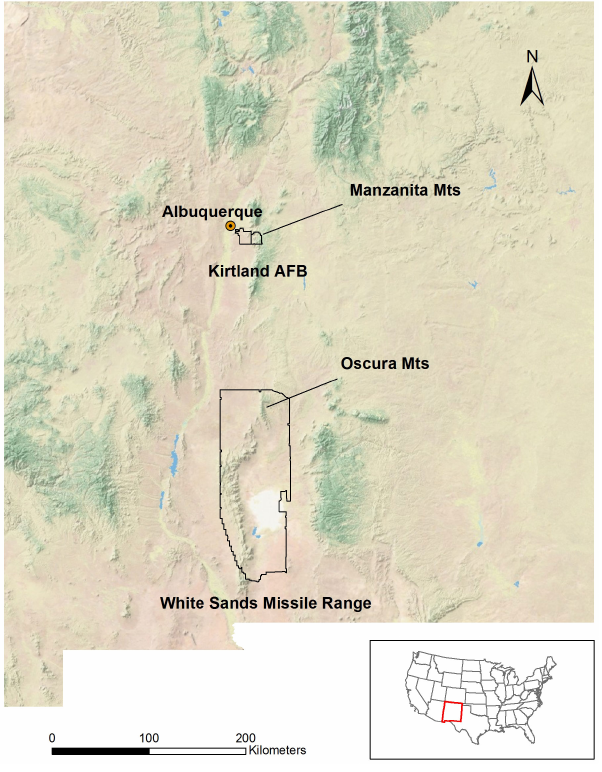
Fig. 2 . Map showing study areas in New Mexico, USA: Kirtland Air Force Base (Manzanita Mountains) and White Sands Missile Range (Oscura